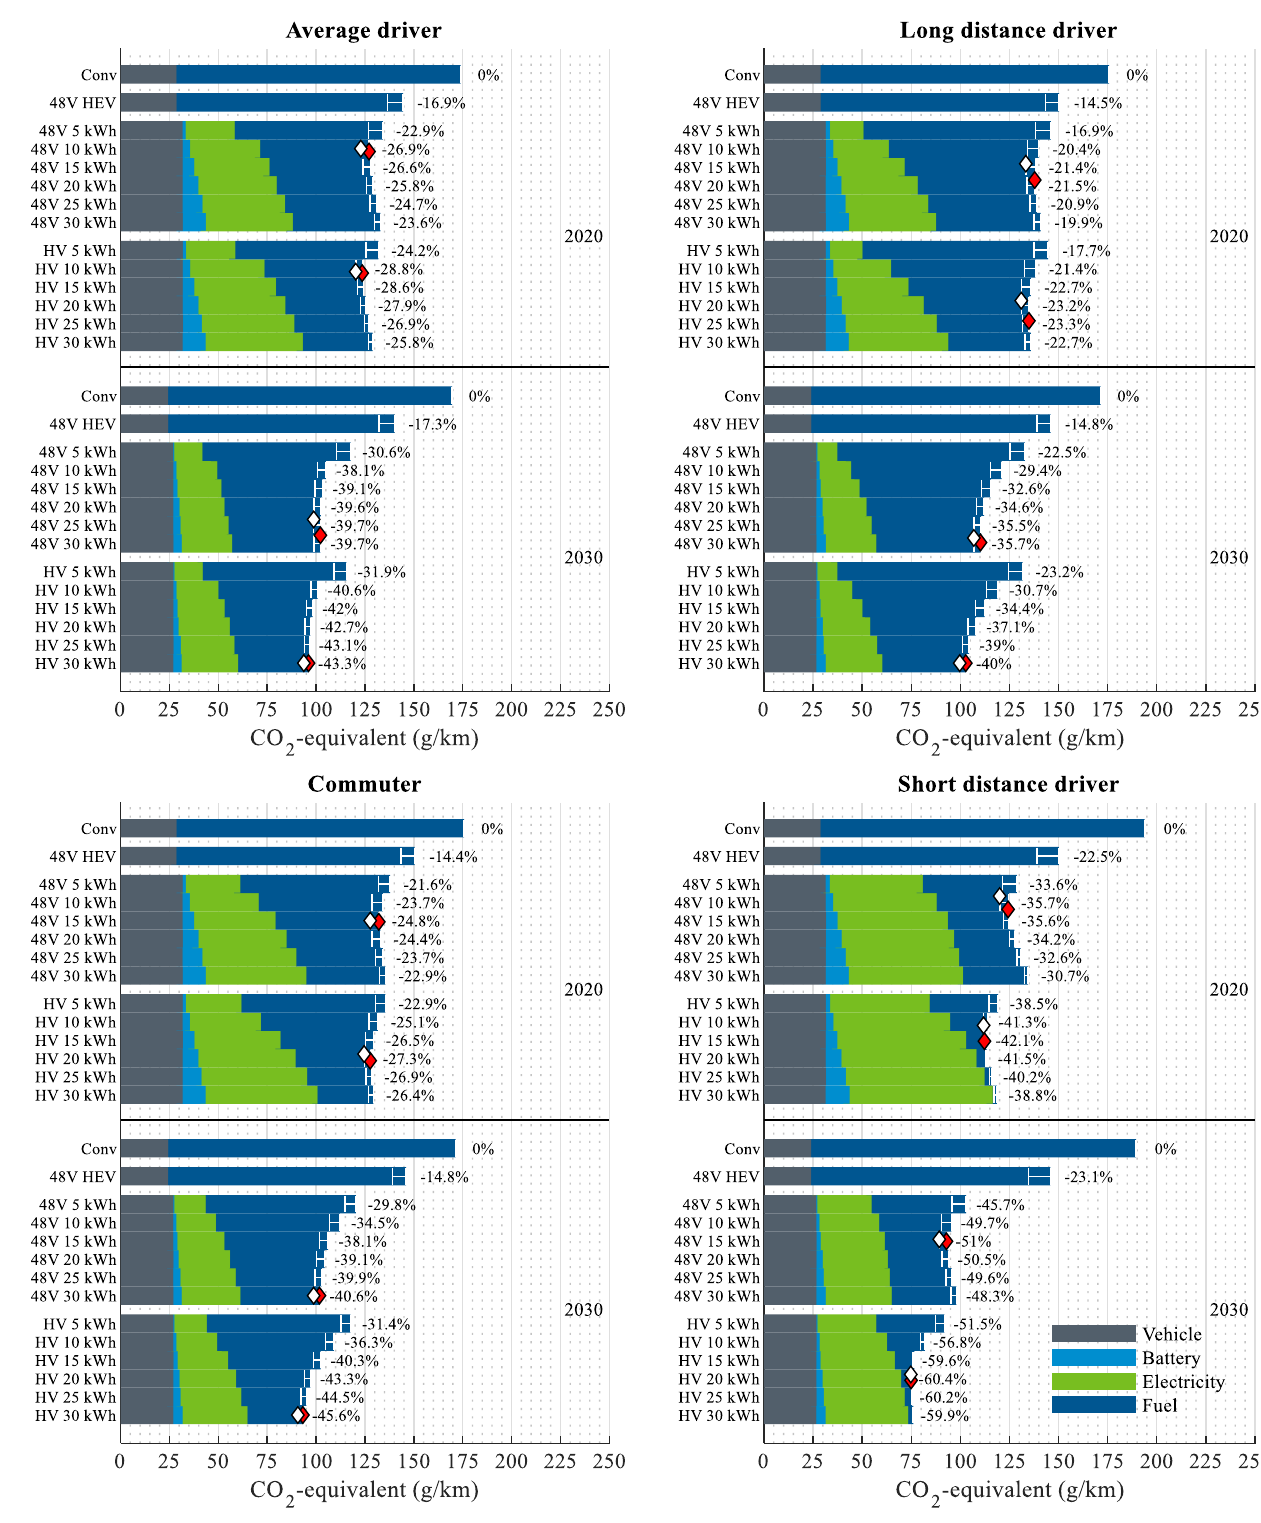
Figure 7. Use case LCA emissions for the subcompact vehicle and ECMS. The colors indicate the emission sources. The white error bars show EMSs optimization potentials with DP. The diamonds mark the minimum LCA systems for ECMS (red) and DP (white).